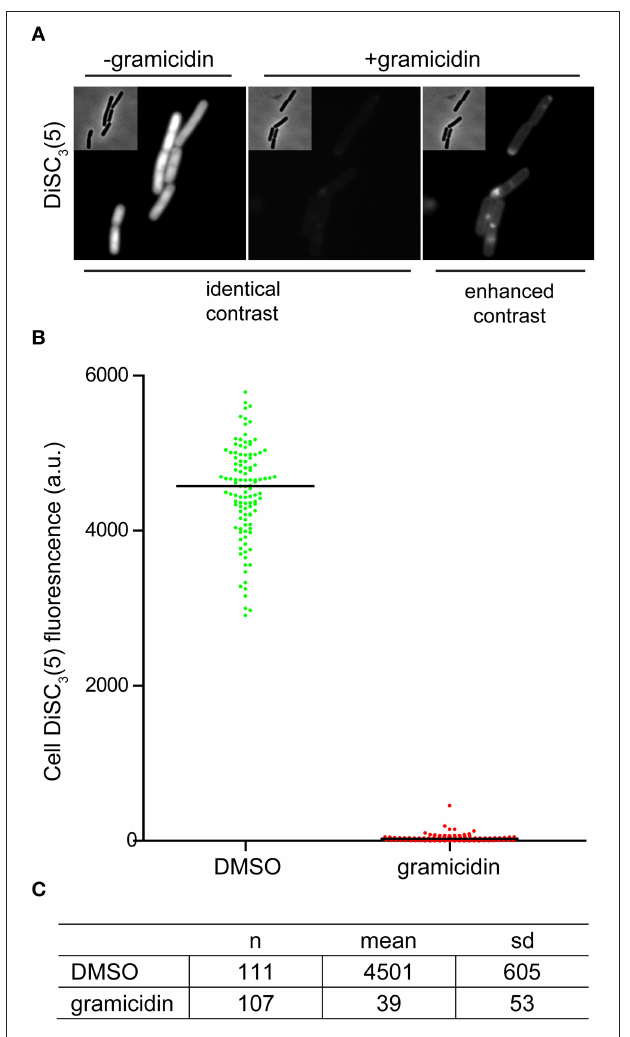
FIGURE 5 | Microscopic single-cell measurement of membrane potential using DiSC 3 (5). (A) Fluorescence microscopy of DiSC 3 (5)-stained B. subtilis cells in the absence (left panel) and presence (right panels) of the small cation channel forming antimicrobial peptide gramicidin (5 µ M). In the left, the polarized and depolarized cells are depicted with identical contrast settings providing a direct comparison. On the right, the contrast of the fluorescence image is enhanced in order to visualize the remaining staining. (B) The cellular DiSC 3 (5) fluorescence was quantified for logarithmic growth phase cells in the presence and absence of gramicidin (5 µ M). The column scatter plot depicts the individual single-cell intensities and the median thereof. (C) The mean and standard deviation of the DiSC 3 (5)-fluorescence for the individual cells analyzed in graph (B) are shown. Strain used: B. subtilis 168 (wild type).